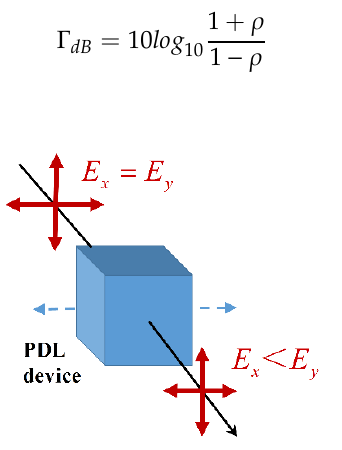
Figure 1. Schematic of polarization-dependent loss (PDL).